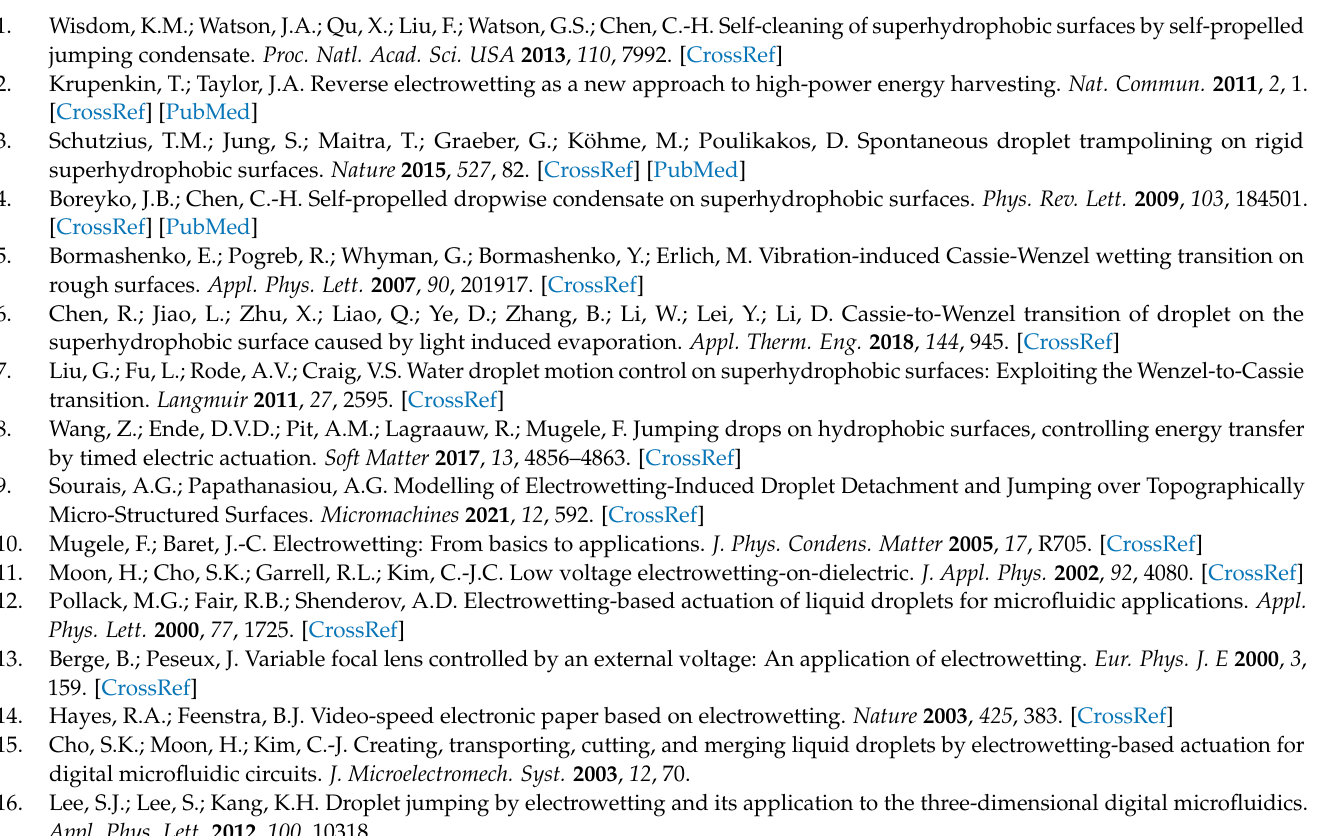
per second; Figure S5: Experimental values of droplet velocity (dark line) and acceleration (pink line) as a function of time for the droplet trampolining on a superhydrophobic surface, driven by electrowetting force applied during the spreading phase of each impact cycle. The acceleration has been normalized by the gravitational acceleration g; ESI 6: Droplet centroid velocity and acceleration duration trampolining